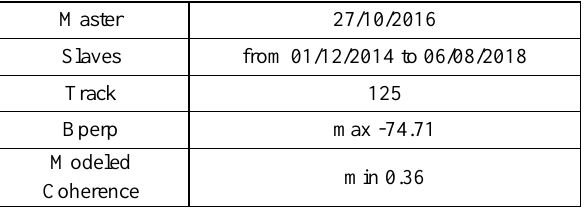
Table 2 . Overview of the image stack and selection of the optimal MT-InSAR master image.